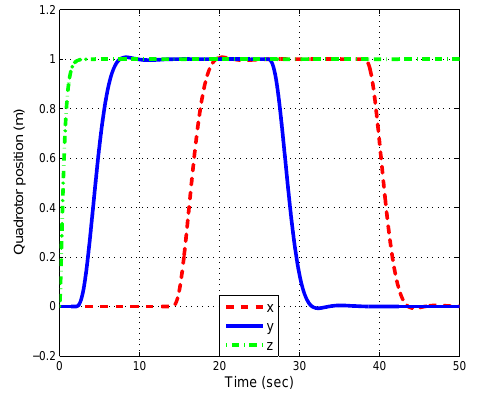
Figure 5. Quadrotor position.